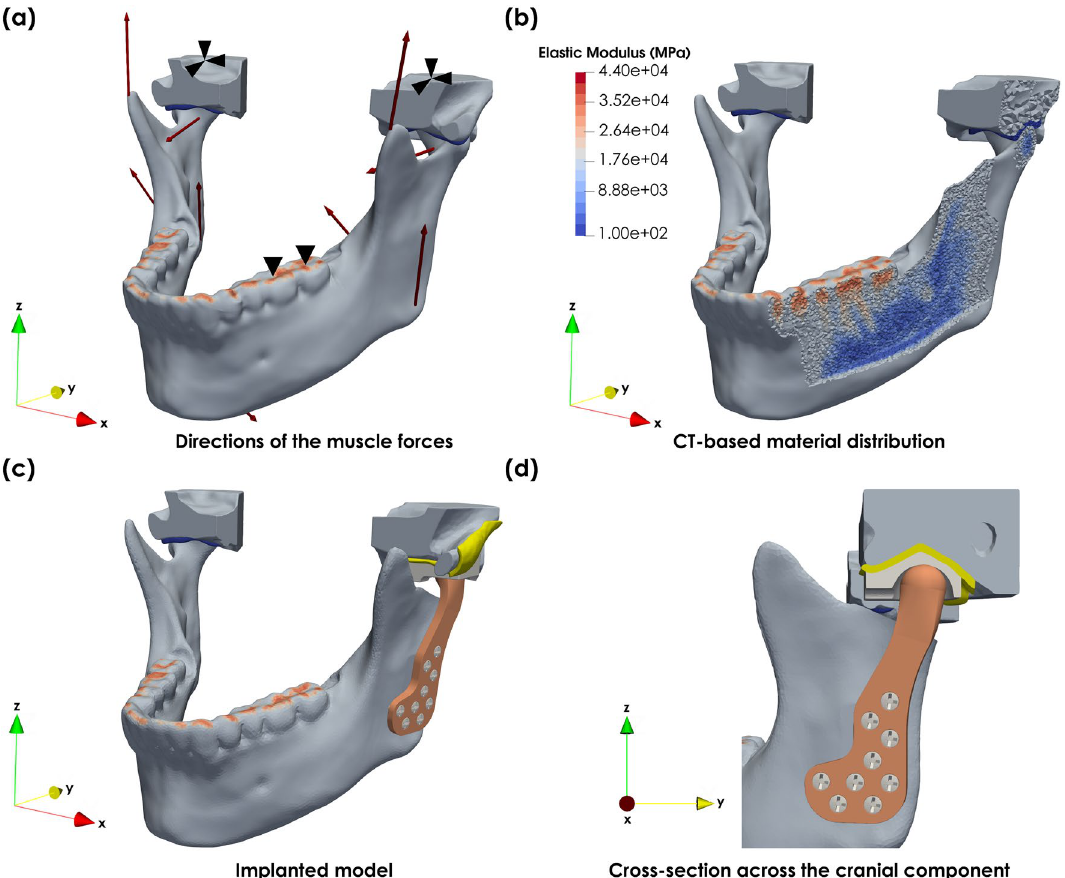
Figure 1. Patient-specific model of the human mandible: ( a ) musculoskeletal model of the intact mandible, ( b ) greyscale-based material distribution across the intact mandible, ( c ) finite element model of the mandible with the patient-specific implant and ( d ) cross-section along the mid-plane of the scustomised cranial component of TMJ replacement system.